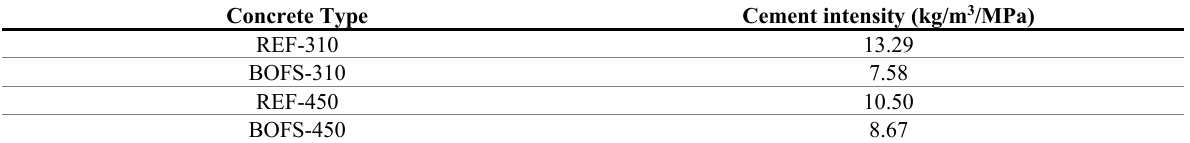
Table 9. Cement intensity of steel slag and reference concretes